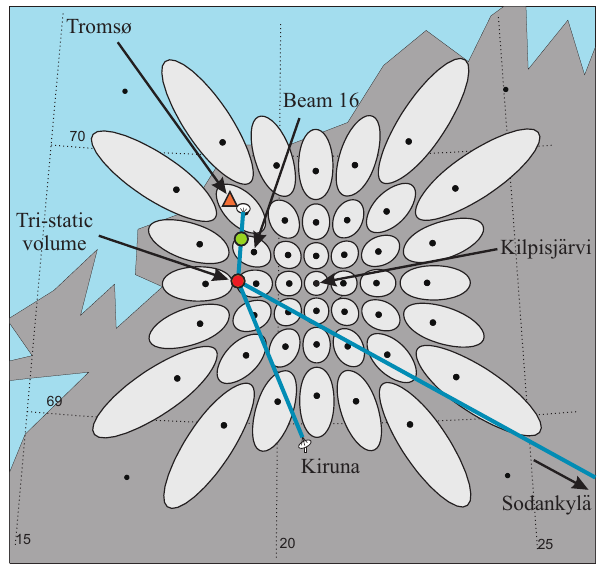
Fig. 1. Experimental setup diagram showing the IRIS and EISCAT fields-of-view. The dots (ellipses) represent the intersection of the principal directions ( − 3dB riometer beams) with the ionosphere at a height of 90km. The − 3dB beams at the corners of the array are not shown as the antenna side lobes are too large. The 3 blue lines show the receiver beams from the EISCAT in the CP1-K common mode. The red circle shows the position of the tri-static volume at an altitude of 278km. The green circle illustrates the position of the tri-static volume projected down the magnetic field line to 110km in the E-region. At this height it is closest to beam 16 of the IRIS. The orange triangle is the position of the Tromsø magnetometer, which maps close to the projected tri-static